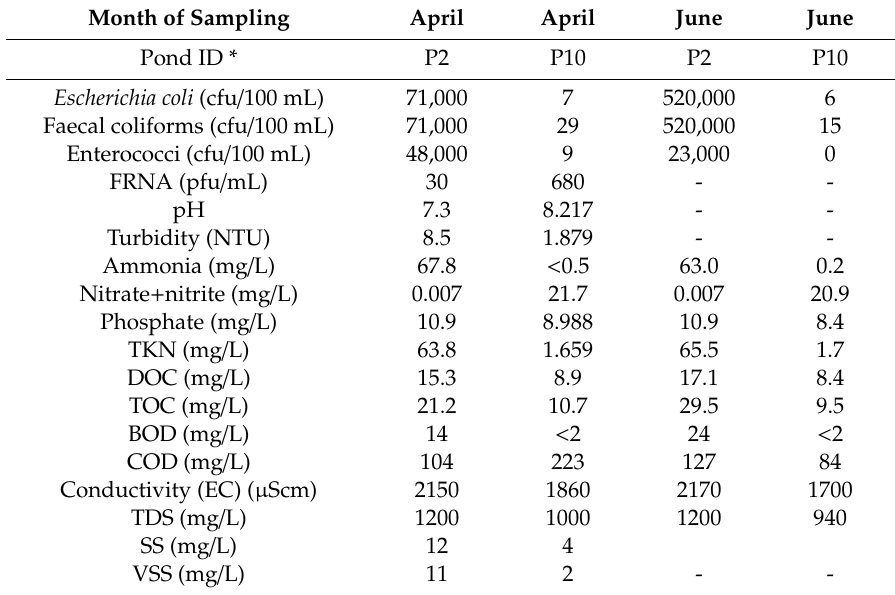
Table 1. Water quality data for Western Treatment Plant Pond